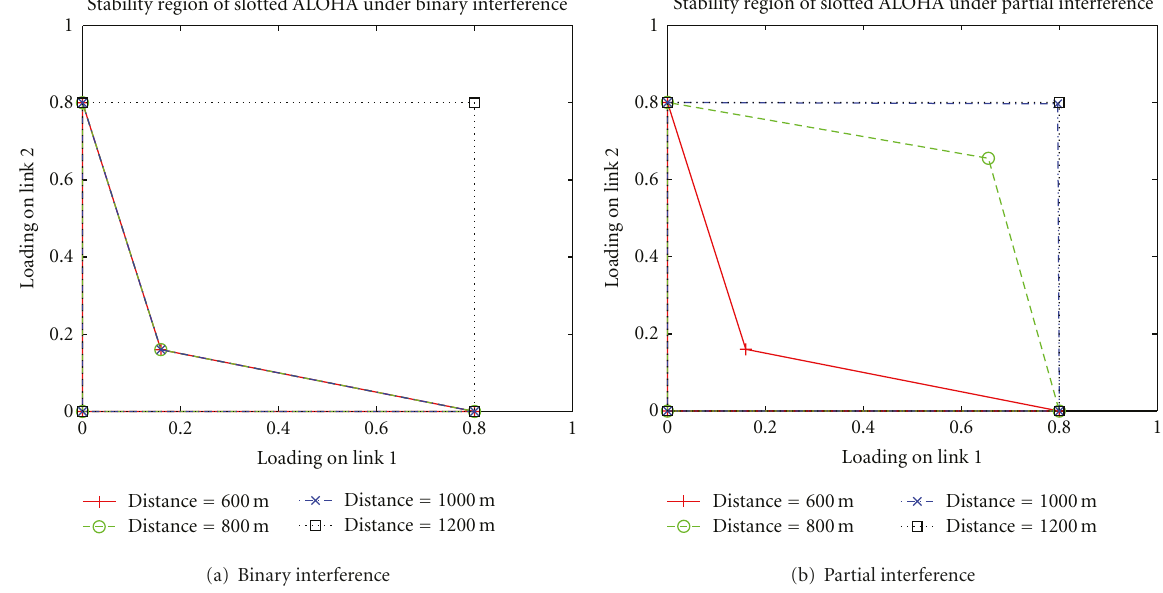
Figure 9: Stability region for M = 2 with transmission probabilities 0.8 under binary and partial interference.